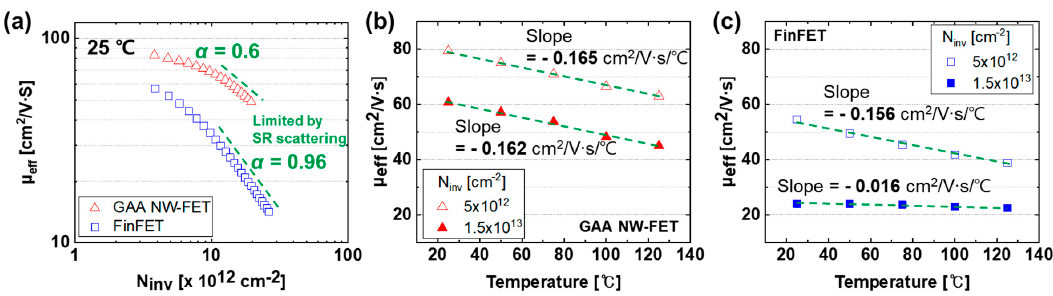
Figure 5. E ff ective mobility ( µ ef f ) behavior comparison between GAA NW-FET and FinFET with L G = Figure 5. Effective mobility ( 𝜇 (cid:3032)(cid:3033)(cid:3033) ) behavior comparison between GAA NW-FET and FinFET with 𝐿 (cid:3008) = 70 nm; ( a ) 𝜇 (cid:3032)(cid:3033)(cid:3033) - 𝑁 (cid:3036)(cid:3041)(cid:3049) . Temperature dependence of 𝜇 (cid:3032)(cid:3033)(cid:3033) for ( b ) GAA NW-FET and ( c ) FinFET. 70 nm; ( a ) µ ef f - N inv . Temperature dependence of µ ef f for ( b ) GAA NW-FET and ( c )